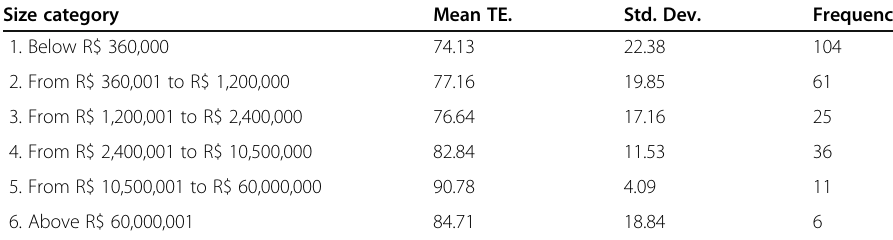
Table 4 Mean TE of each size category of companies Size category Mean TE. Std.